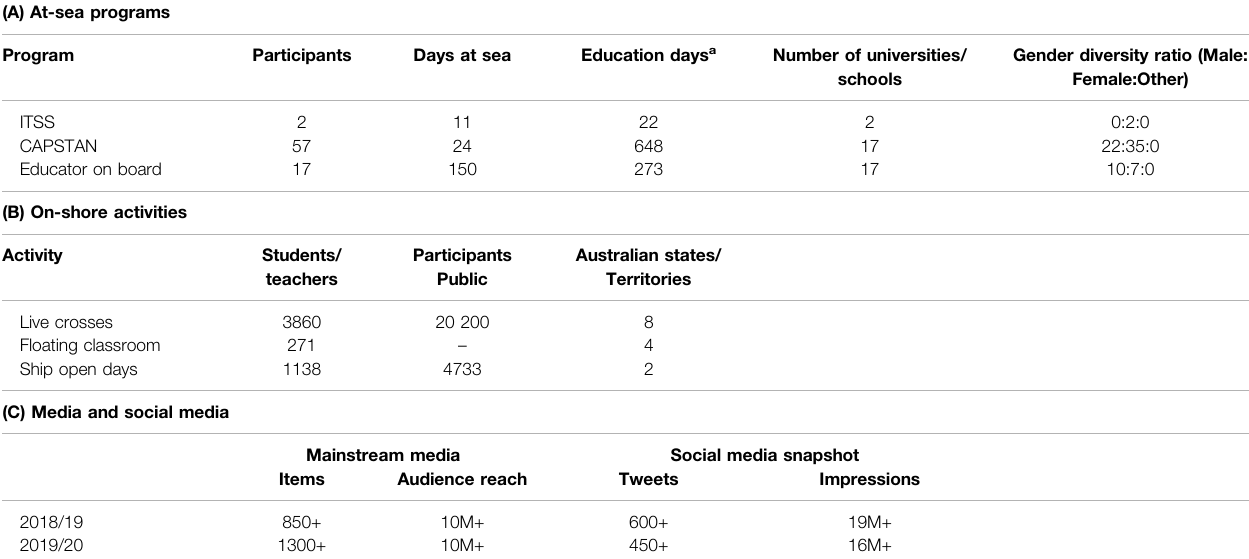
TABLE 1 | Summary statistics for the MNF Outreach Program for (A) at-sea programs 2016 – 2020, (B) on-shore activities 2016 – 2020 and (C) media and social media activities 2018 –